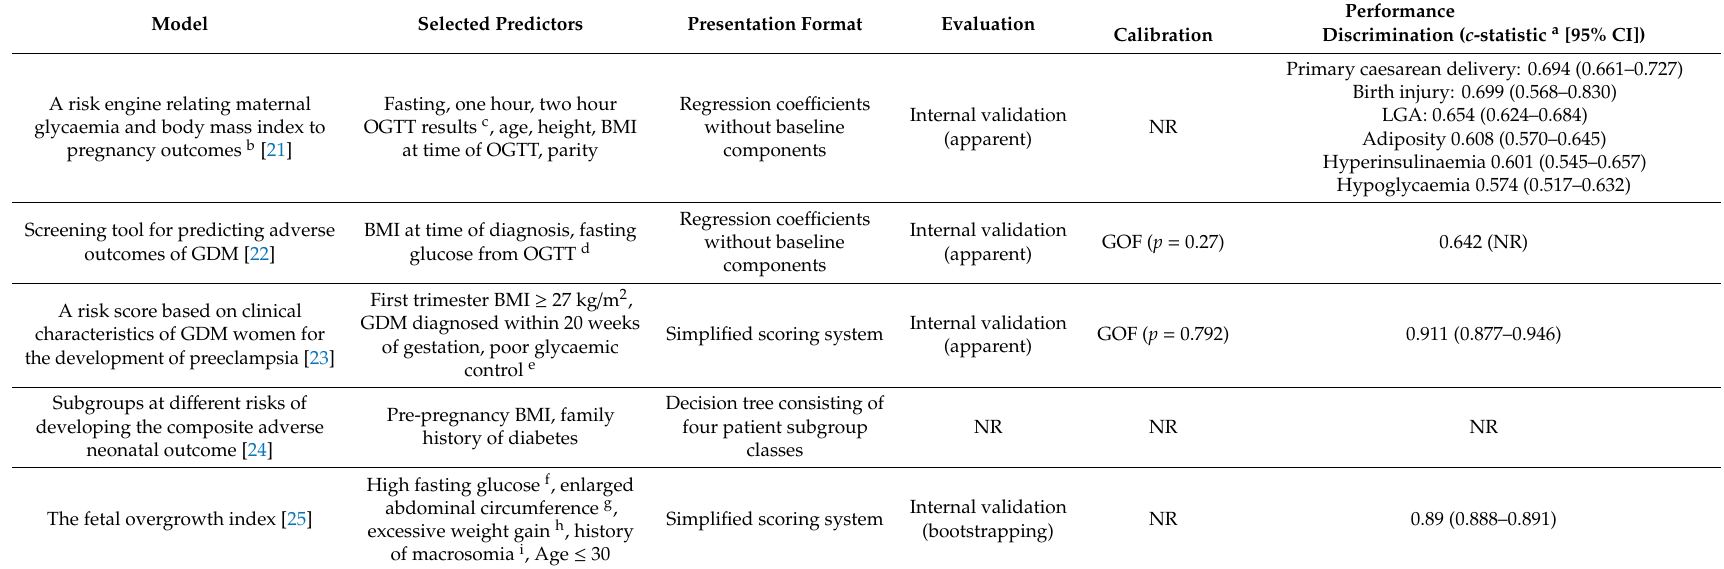
Table 5. The selected predictors, presentation format and performance of models for pregnancy complications in women with gestational